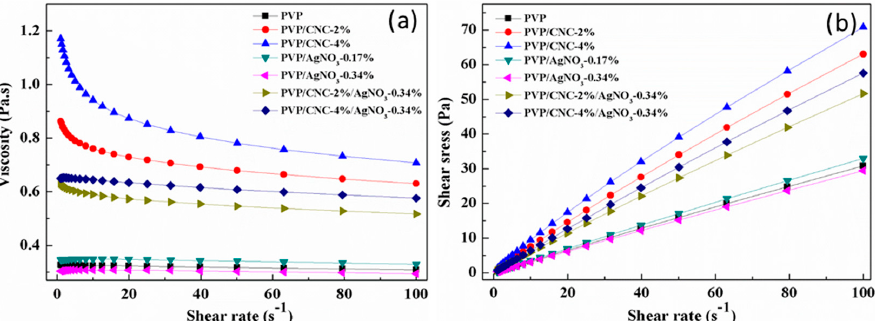
Figure 1. Rheological behavior ( a ) viscosity and ( b ) shear stress vs. shear rate of pure PVP, PVP/AgNO 3 , PVP/CNC, and PVP/CNC/AgNO 3 suspensions systems. Table 2. Calculated parameters for pure PVP solution, PVP/AgNO 3 , PVP/CNC, and PVP/CNC/AgNO 3 suspensions systems using Bingham plastic (BP), and power law (PL) models.